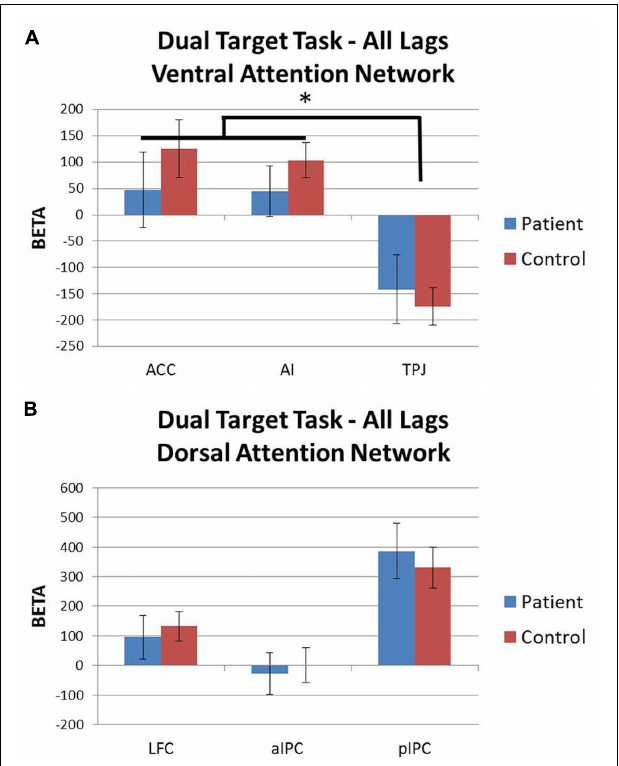
FIGURE 6 | Dual target task vs. single target task ROI analysis by lag. (A) Controls showed significantly greater deactivation of temporo-parietal junction (TPJ) than patients across lags. (B) Patients showed greater activation of posterior intraparietal cortex (pIPC) than controls across